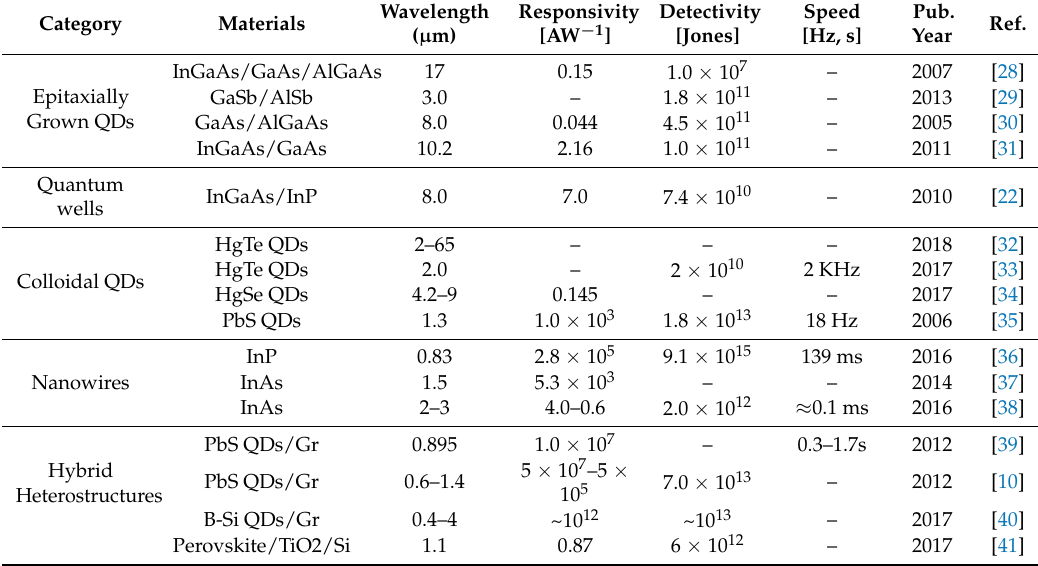
Table 1. The list of nanostructured materials and their performance parameters for IR